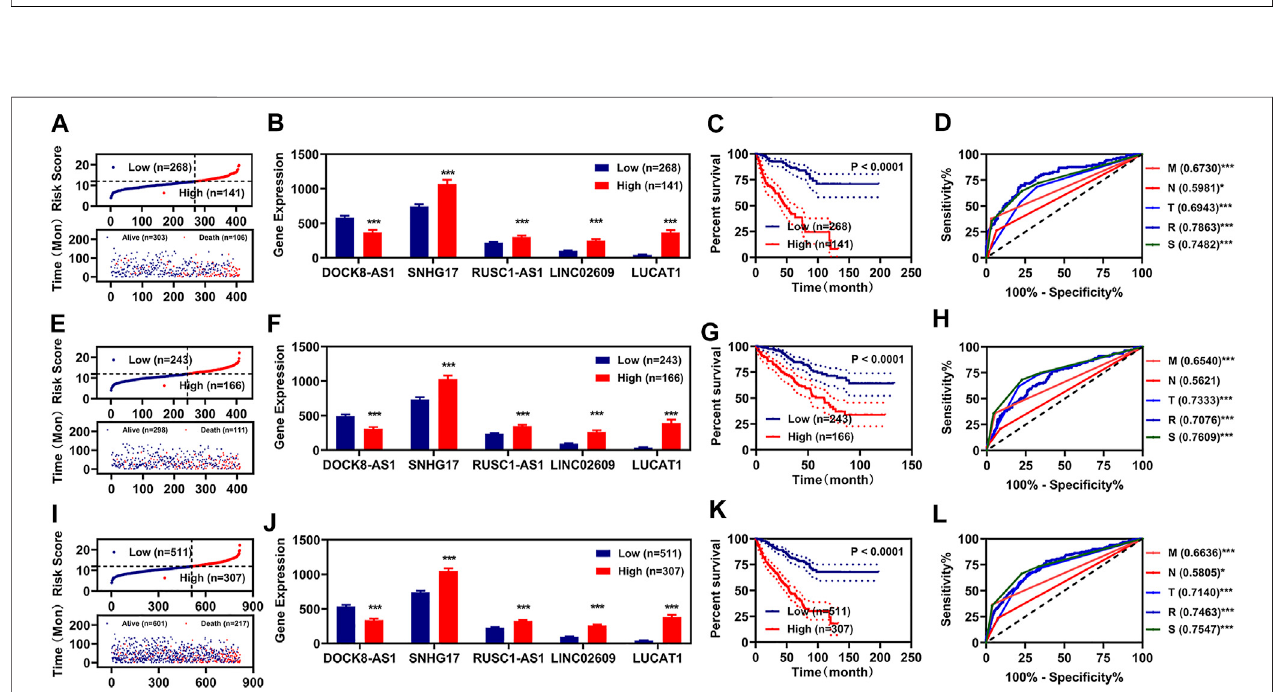
FIGURE 2 | Development of prognosis signatures based on FR-DEMs and FR-DEGs. (A – D) Distribution of the risk values (up) and survival status (down) (A) , expression (B) , Kaplan – Meier curves (C) , and ROC curve (D) of the risk assessment model in the training group. (E – H) Distribution of the risk values (up) and survival status (down) (E) , expression (F) , Kaplan – Meier curves (G) , and ROC curve (H) of the risk assessment model in the validation group. (I – L) Distribution of the risk values (up) and survival status (down) (I) , expression (J) , Kaplan – Meier curves (K) , and ROC curve (L) of the risk assessment model in the entire group. * p < 0.05, ** p < 0.01, *** p < 0.001.FR-DEMs, ferroptosis-related differentially expressed miRNAs; FR-DEGs, ferroptosis-relateddifferentially expressed genes;ROC,receiver operating characteristic.